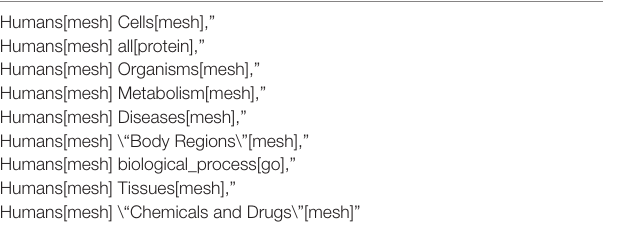
TaBle 1 | Queries used to gather data from